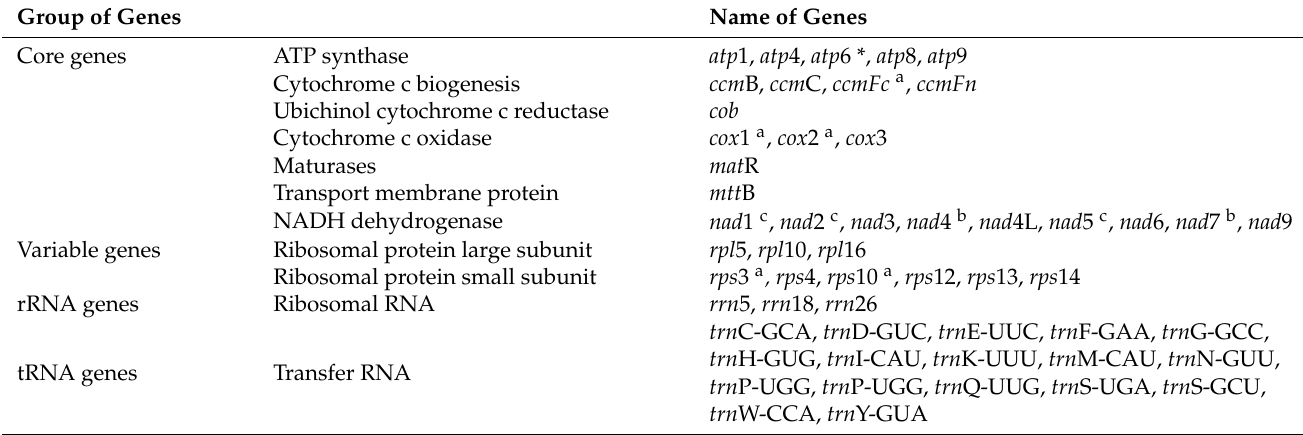
Table 2. Gene contents in the mitogenome of S. officinalis .